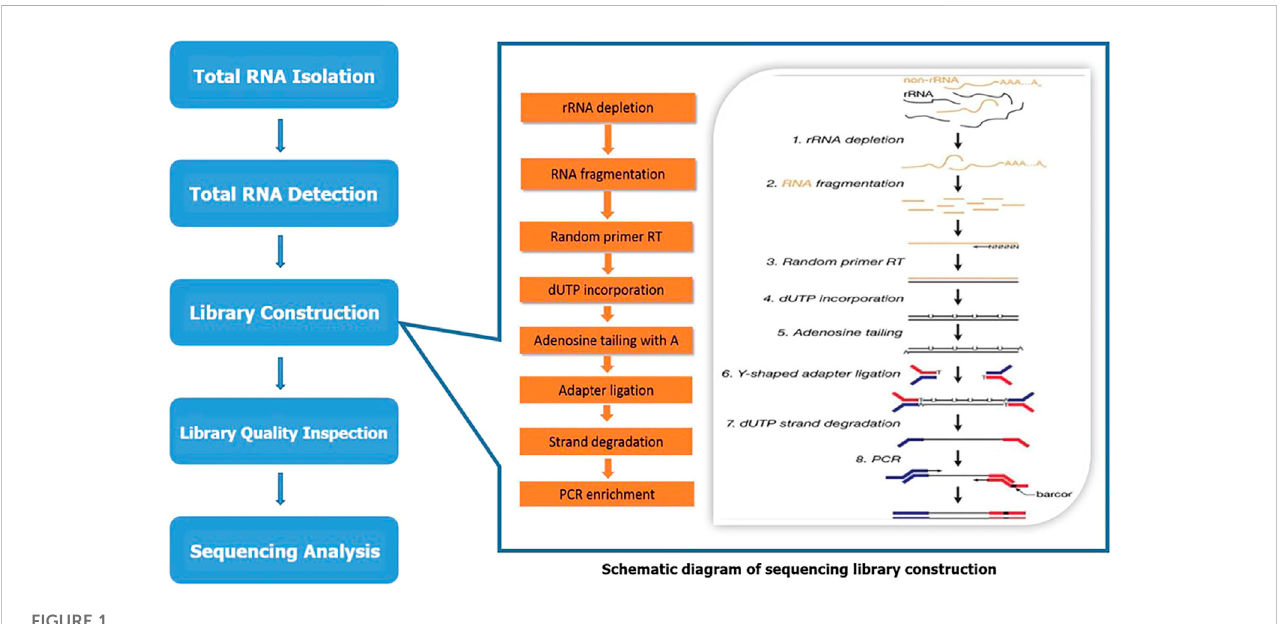
FIGURE 1 The schematic diagram of